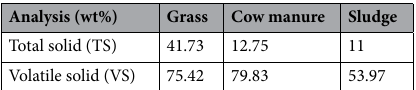
Table 2. Characteristics of digester contents.